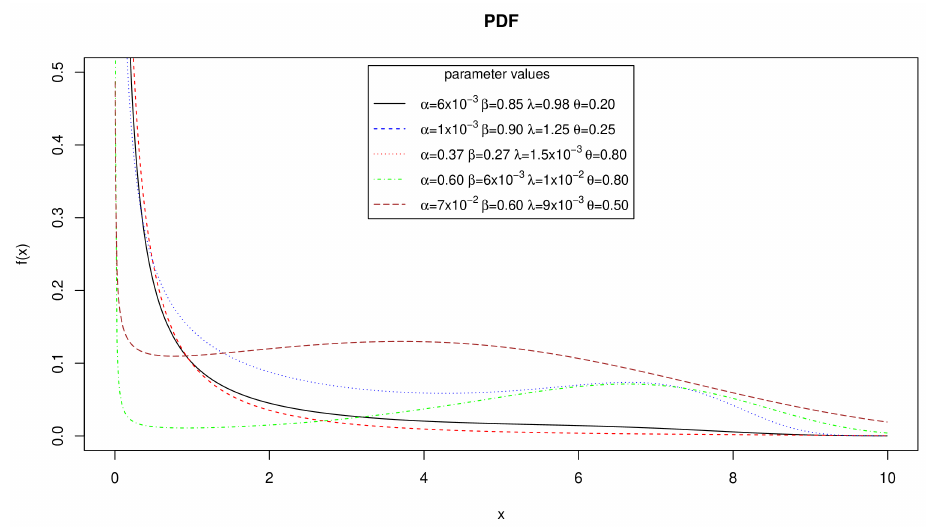
Figure 1. PDF for some parameter values derived of